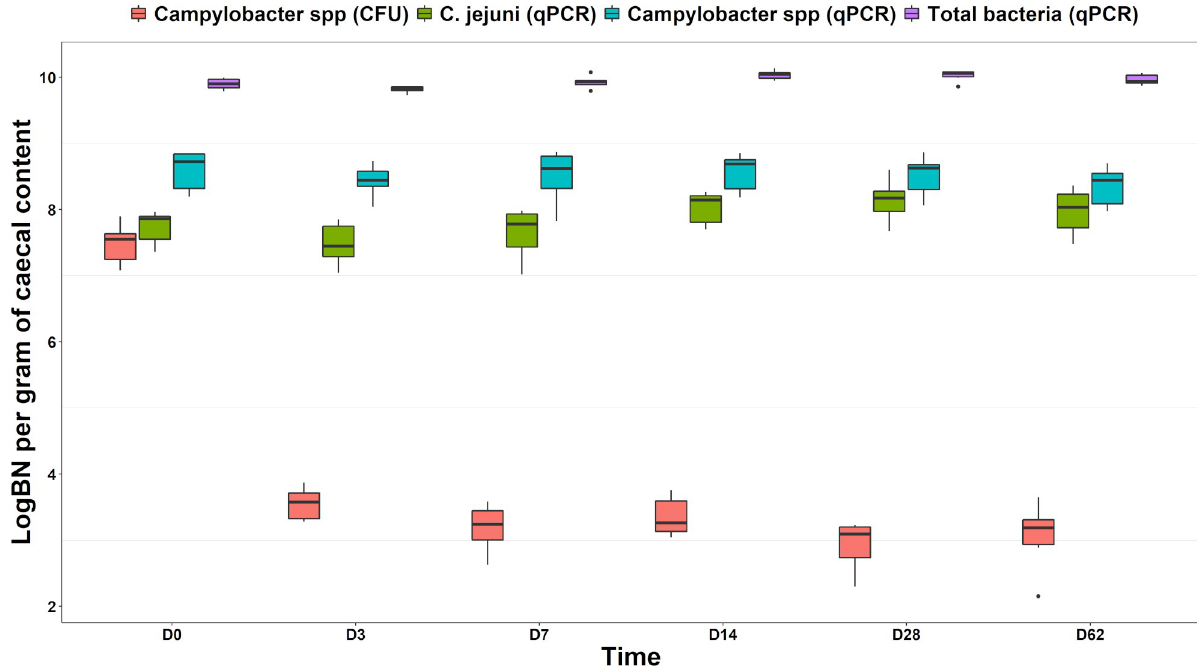
Fig 1. Log 10 bacterial concentration of Campylobacter genus, C . jejuni and total bacteria measured via qPCR and culture-based test throughout the six experimental time points.